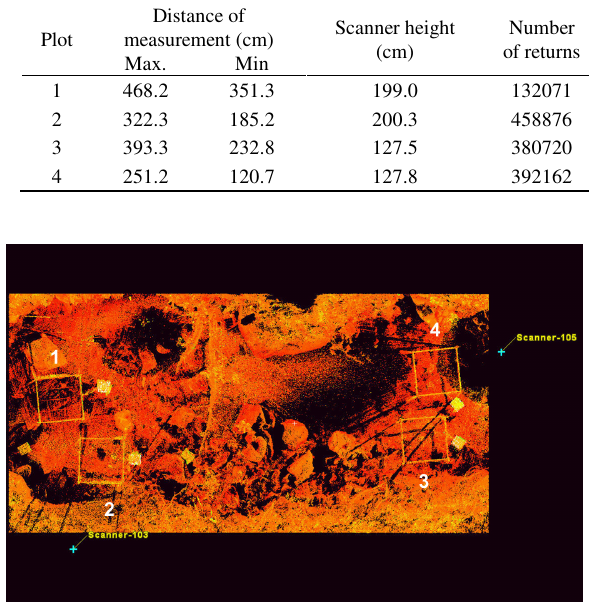
Figure 6. TLS measurement over study area. Numbers correspond to the plot names.